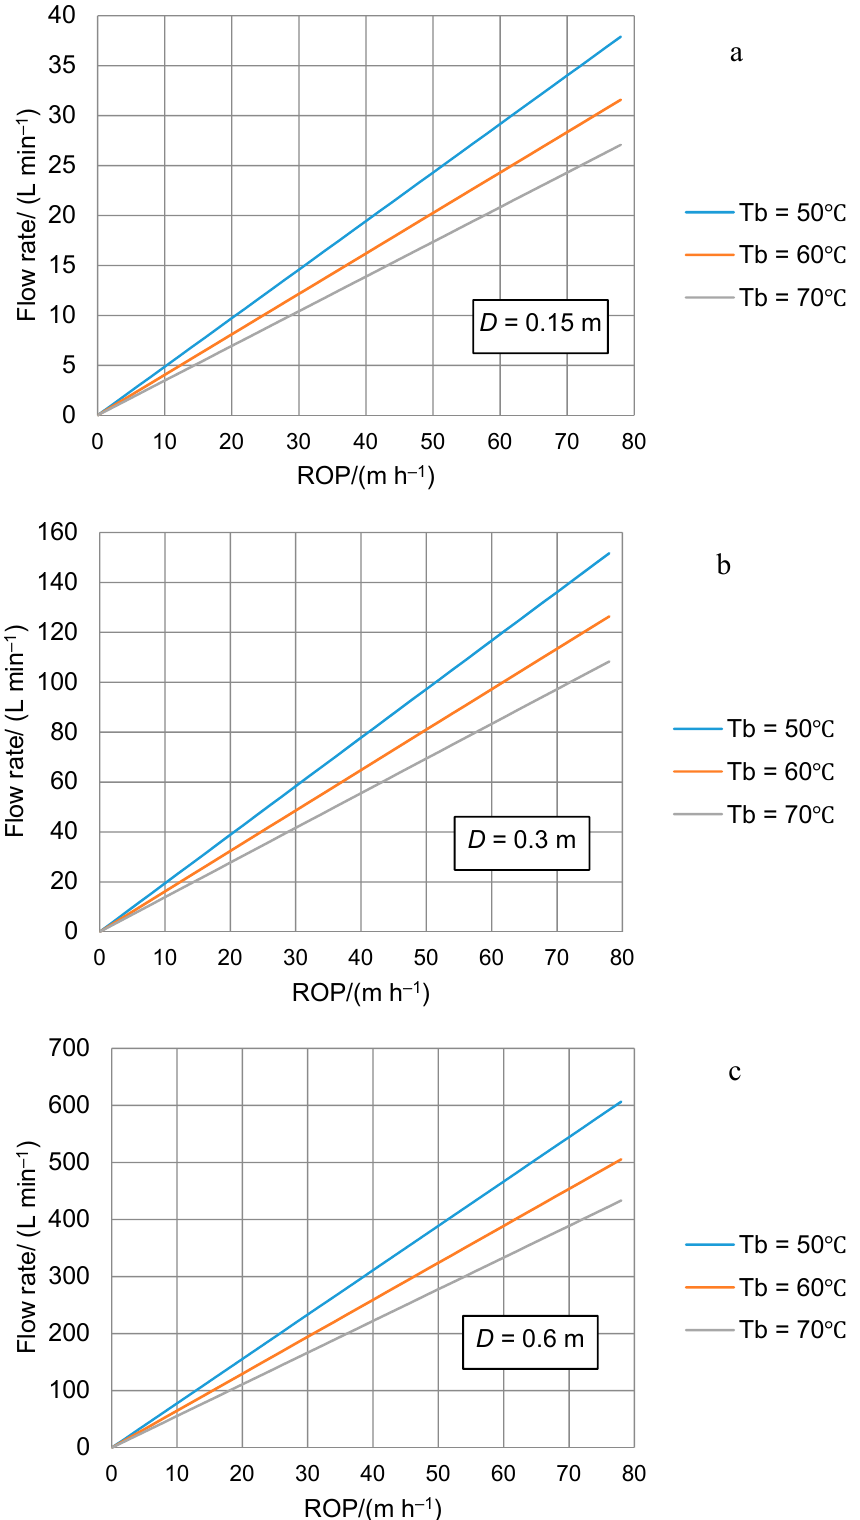
Figure 5. Minimum flow rate vs. ROP to drill a hole with average diameters of 0.15 m ( a ), 0.3 m ( b ), and 0.6 m ( c ) at different bottom temperature of drilling water T b .